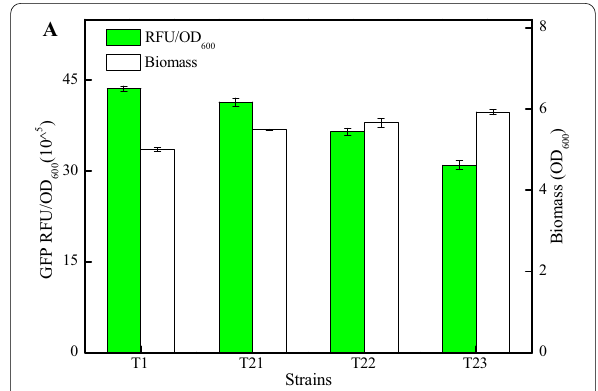
Fig. 4 Effect of different U-tract lengths on intrinsic terminator T1. A Green fluorescence intensities and cell biomasses of recombinant strains with different terminators